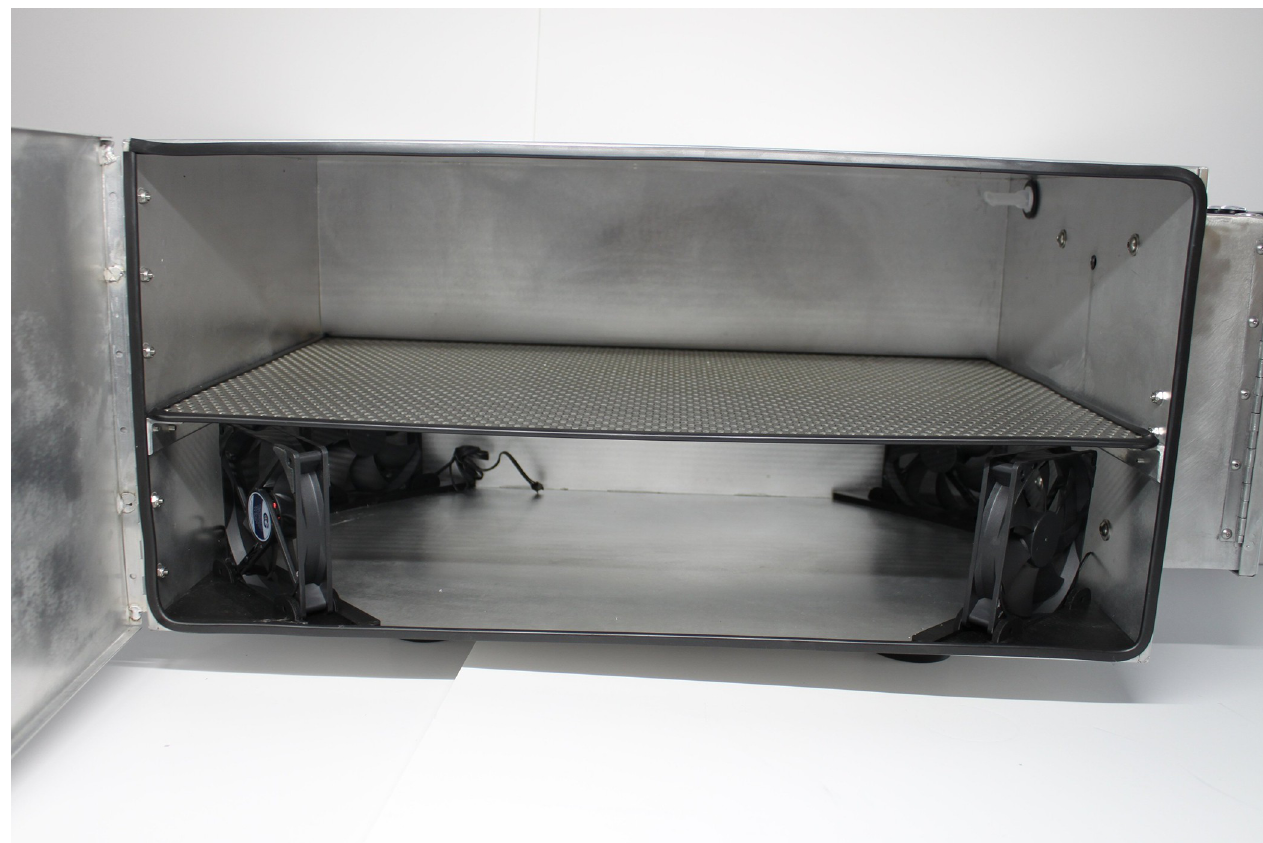
Fig 2. Arca interior demonstrating mesh rack, circulating fans, and Venturi tube